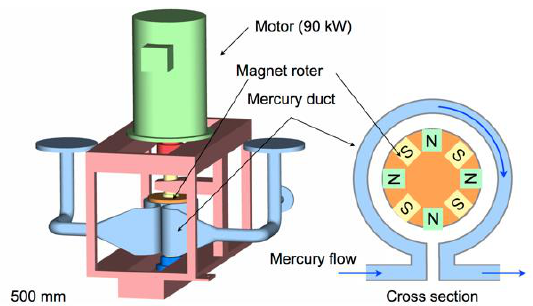
Figure 4. Schematic view of the permanent magnet rotating type induction pump (PM-pump).